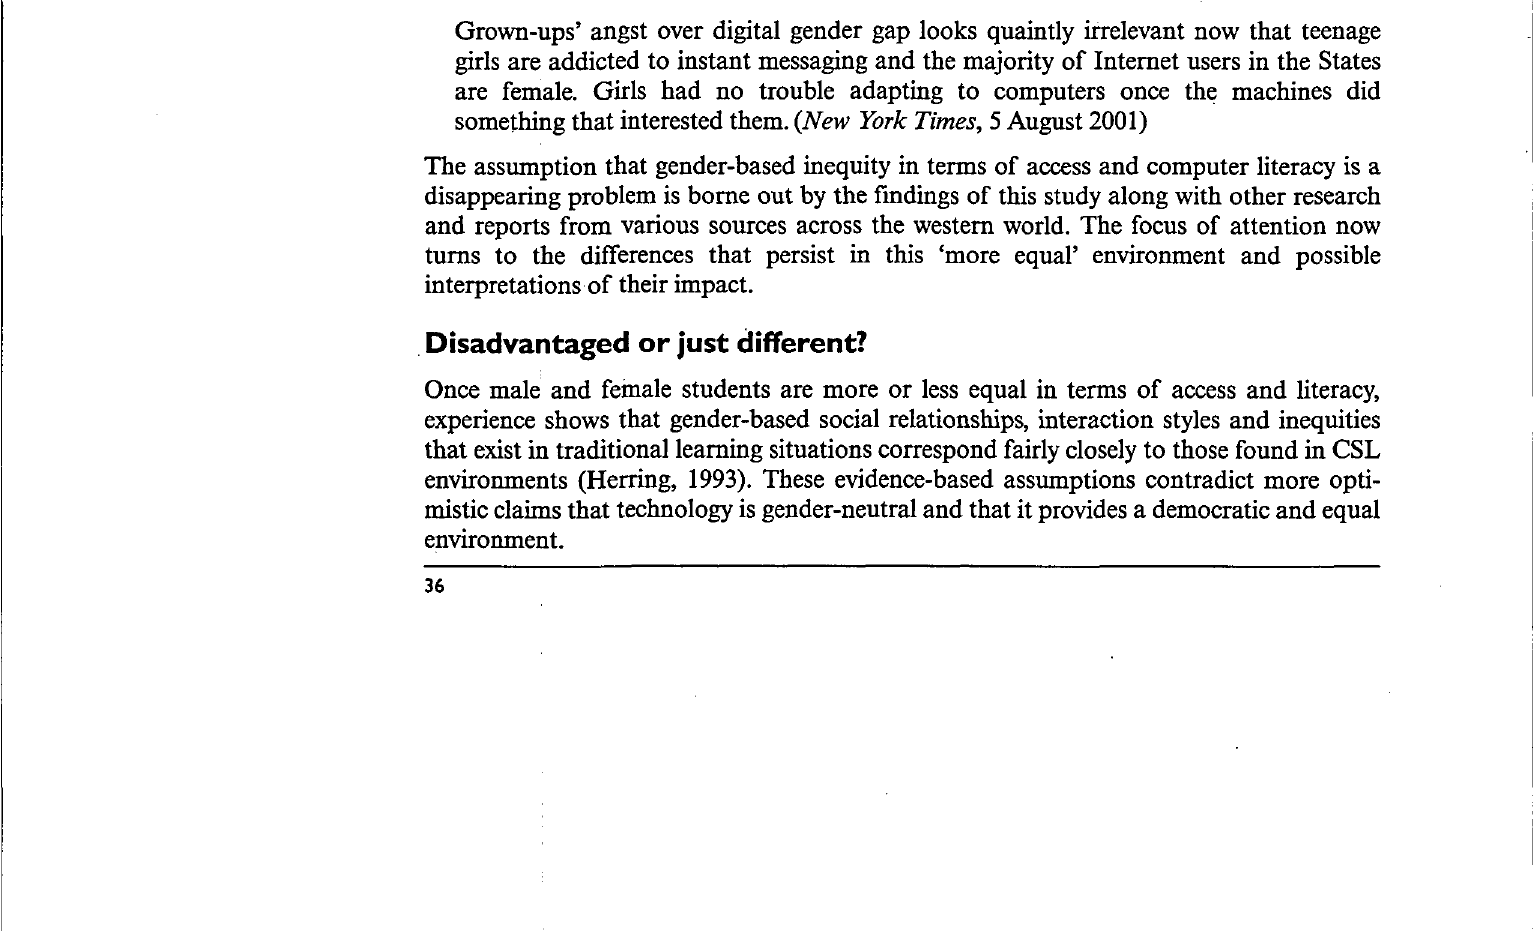
figure 2: Percentage of the group responding either'important'or'vital'to the question 'How important do you think that computers will be to your university